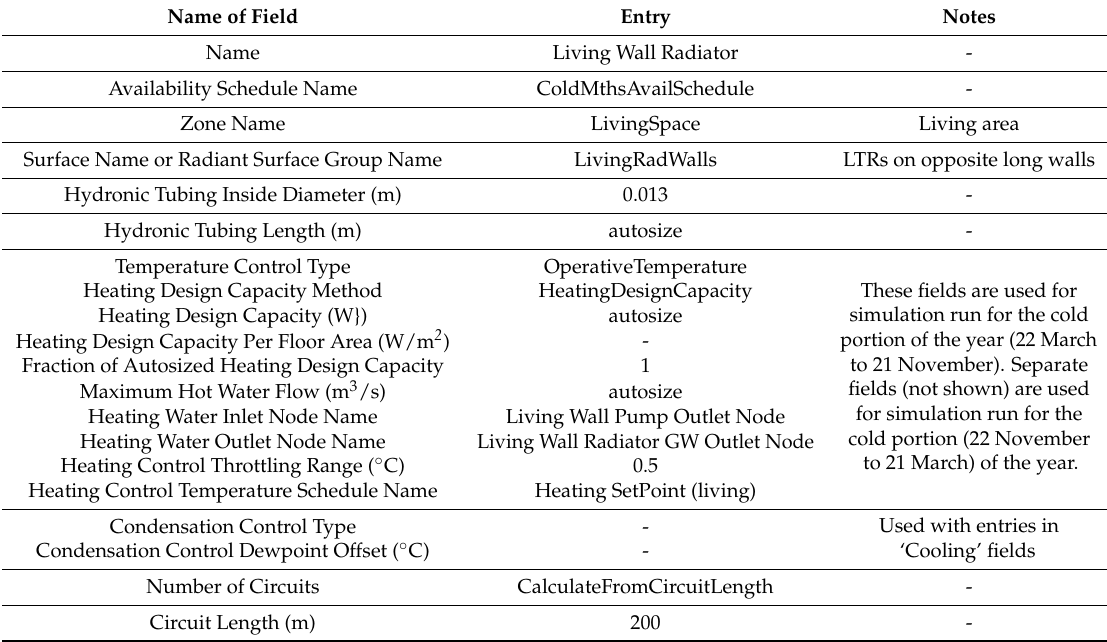
Table 4. The LowTemperatureRadiant:VariableFlow object modelled for heating.